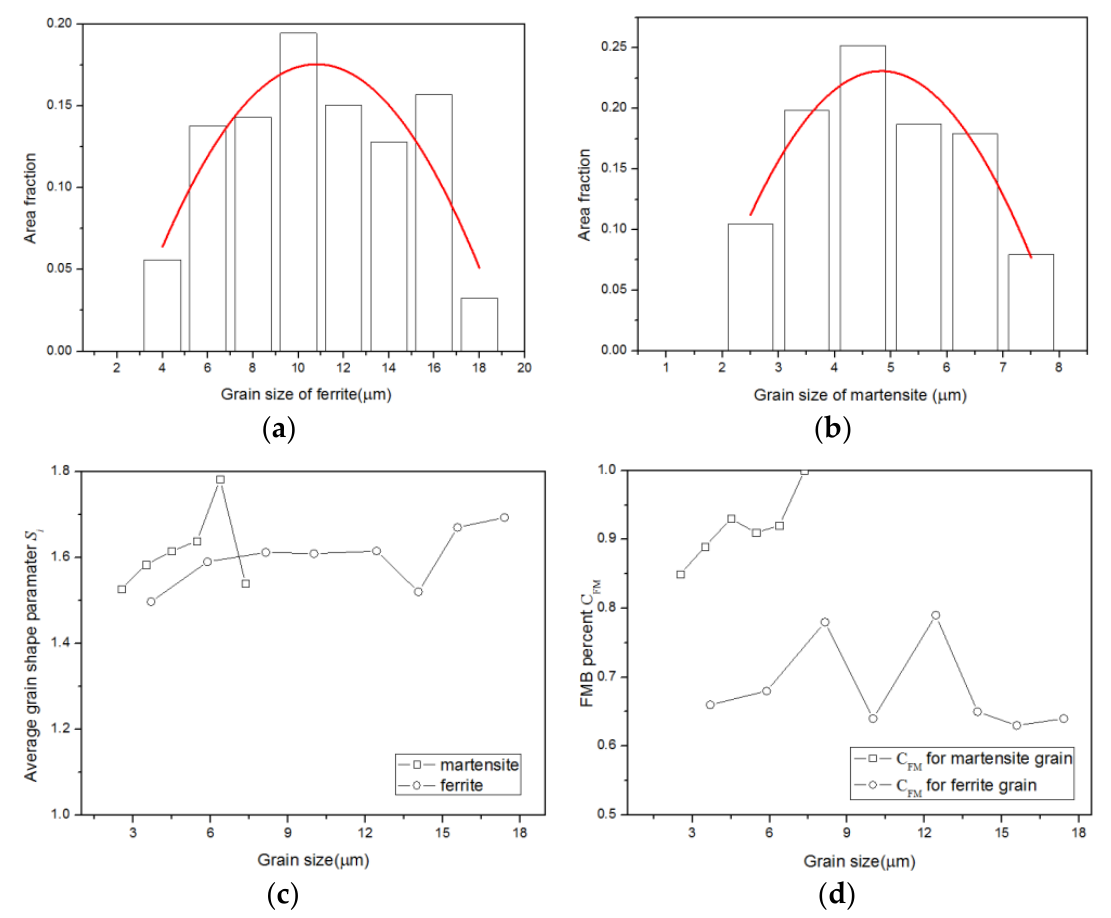
Figure 8. Distribution of the grain characteristic, ( a ) grain size of ferrite, ( b ) grain size of martensite, ( c ) average grain shape parameter S i , and ( d ) FMB percent C FM .